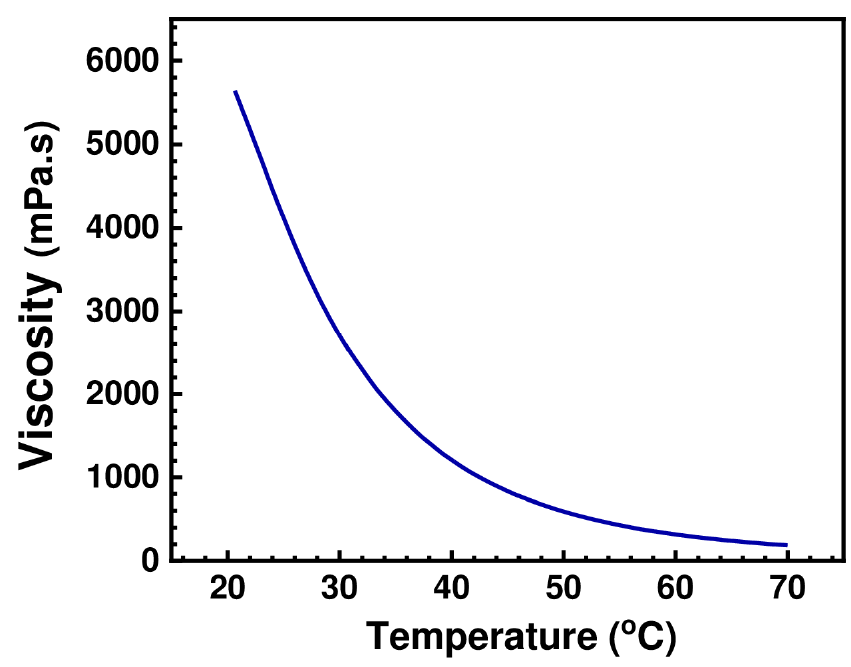
Figure 6. The viscosity of (BMIM)(HQS)) in the 20–70 ◦ C temperature range. The thermal stability of (BMIM)(Cl) and (BMIM)(HQS) was determined by thermo- gravimetric analyzer in order to know their upper temperature limit. (BMIM)(HQS) resulted in a better thermal stability than (BMIM)(Cl), based on the TGA graph in Figure 7. The onset of thermal decomposition started at 261 ◦ C for (BMIM)(Cl), as previously re- ported in the literature [45], whereas (BMIM)(HQS) started decomposing around 340 ◦ C. This shows a high thermal stability for the RAIL here reported. It well established that anion type plays a major role in determining thermal stability, similar to determining the hydrophobicity of ILs [46,47]. Previous investigations have reported that the thermal sta- bility of ILs with different anions decreases with the increase of the coordinating nature, nucleophilicity, and hydrophilicity of the corresponding anion [46]. This is in agreement with the difference of 80 °C in the onset temperature here measured in favor of HQS anion with respect to Cl. Indeed, it is well known that ILs properties can be tuned by varying the cation or the anion or both. This work and several other previous theoretical and ex- perimental studies [48–53] clearly demonstrated that changing the ionic liquid anion greatly affects its physical properties (including viscosity, thermal stability, and melting point). As a matter of fact, in a study on several ionic liquids containing macrocyclic frag- ments [49], it was clearly demonstrated that replacing the halide anions by TFSI anions considerably decrease the melting point of the resulting IL. Similarly in another study [48], the ionic liquid 1-butyl-3-methylimidazolium bis(trifluoromethyl) phosphinate (BMIM (CF 3 )2PO 2 ) did not show a melting point in the temperature range − 120 to 100 °C; in con- trast, BMIM TFSI has a melting point of − 3 °C [48].